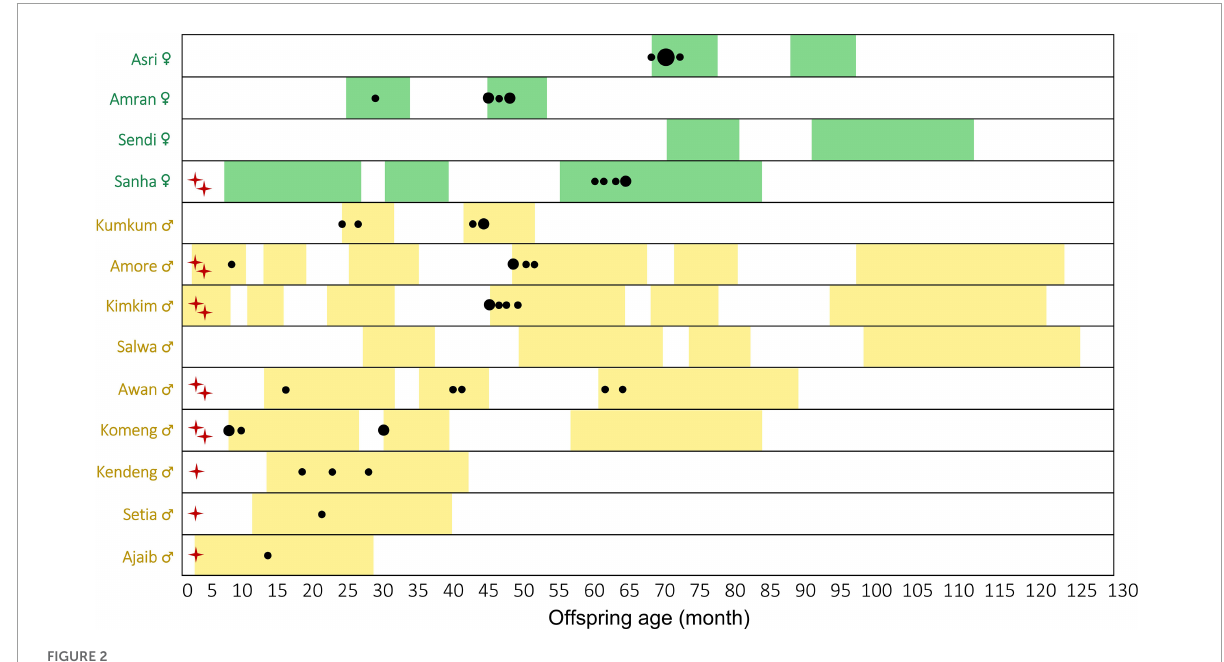
FIGURE2 The age of the earliest (maximum) five recordings of each offspring Hylobates moloch co-singing with mothers in Gunung Halimun-Salak National Park, Indonesia, between 2009 and 2011. The colored bar indicates the data collection period covered in this study. The circle size represents the number of co-singing events (1–3 cases). Red crosses close to the individual name indicate that we included the individuals ( N offspring = 8) in calculating the age of the first co-singing record, and two crosses indicate that we included the individuals ( N offspring = 5) in calculating the age of the first five co-singing records. Individuals without crosses were not included in the first co-singing records because our study period does not cover their early infancy and likely missed the first records.